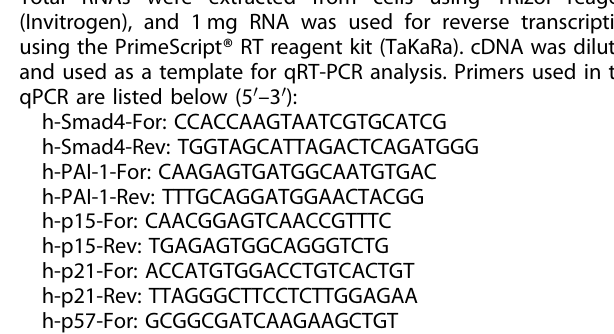
Fig. 7 Tyrosine phosphorylation disables the tumor-suppressing activity of Smad4 in vivo. a Smad4 variants (WT/YF/YE) are re-expressed at similar levels in Smad4 − / − K562 cells. Smad4 − / − K562 cells stably expressing Smad4 or its YE/YF mutants were harvested for total